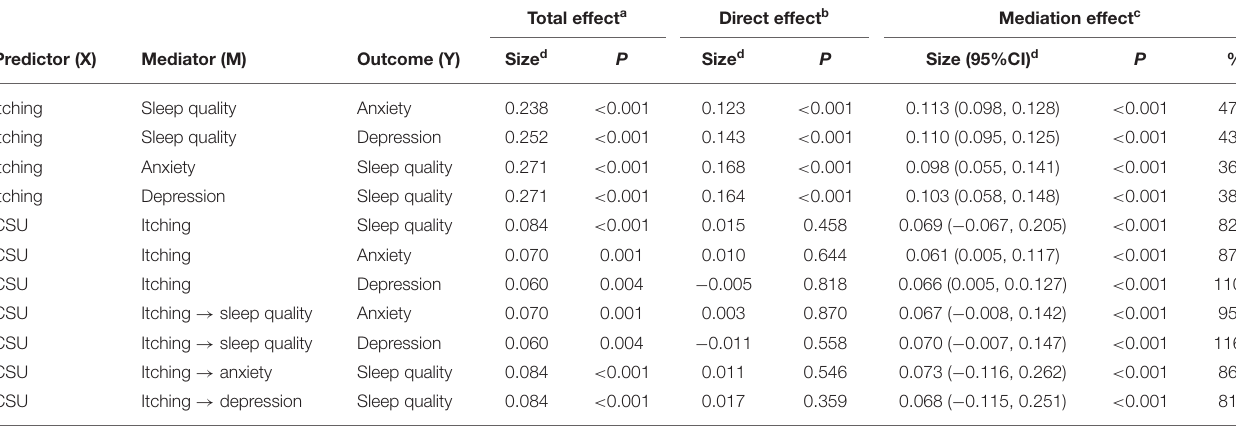
TABLE 3 | Effect of predictors and mediators for sleep quality, anxiety, and